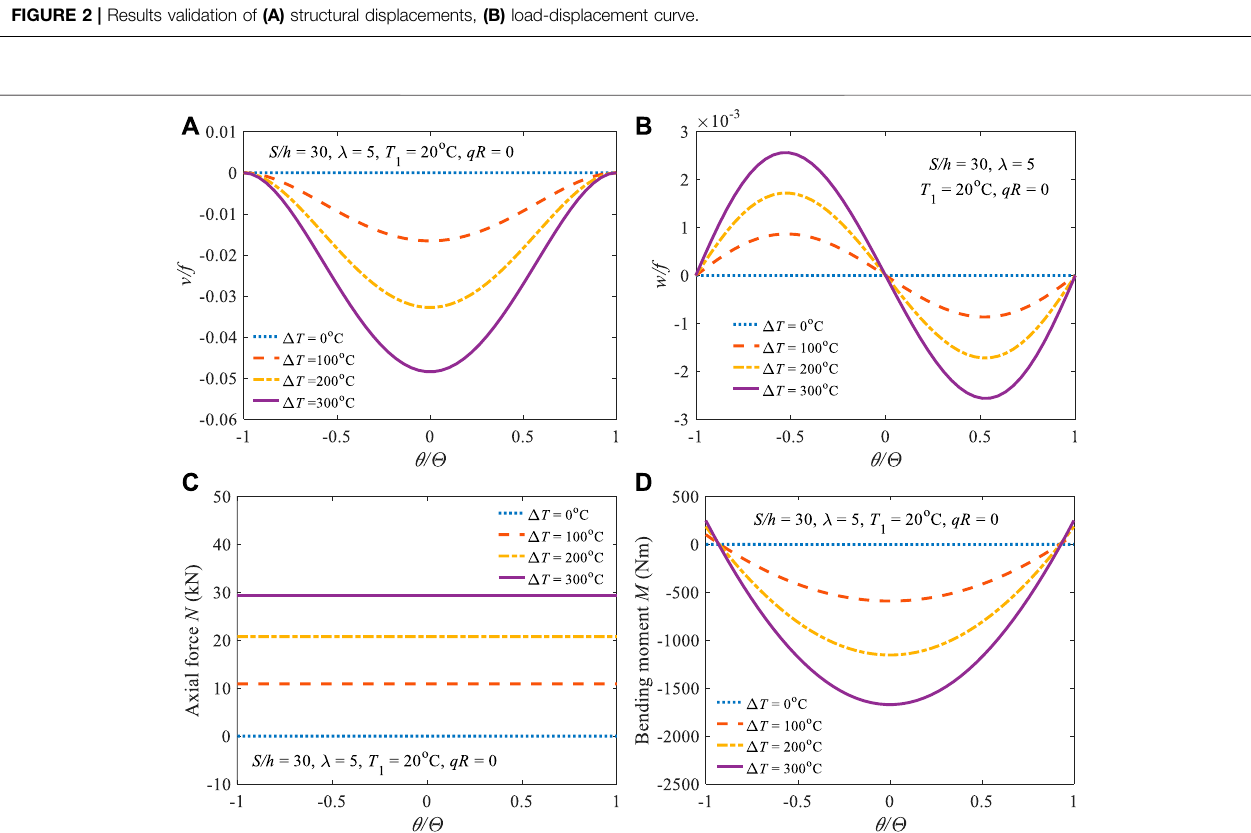
FIGURE3| Structuralresponsesof (A) dimensionlessradialdisplacement, (B) dimensionlessaxialdisplacement,andinternalactionsof (C) axialforce, (D) bending moment.